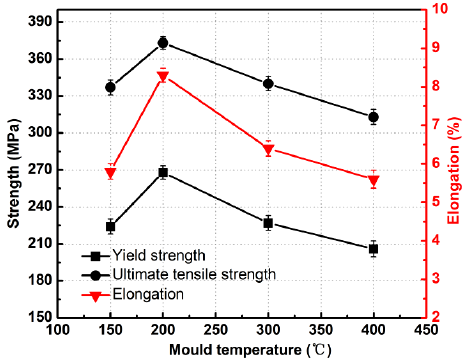
Figure 10. Variations of tensile properties of the composite with mold temperature.